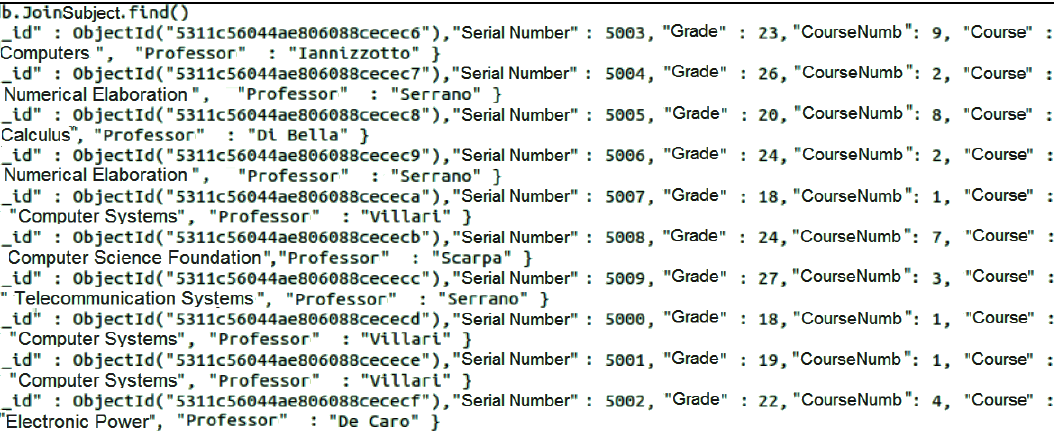
Figure 12. Result of the MongoDB Inner Join performed MongoDB, considering “Exam” and “Class” collections filtered by the “CourseNumb”